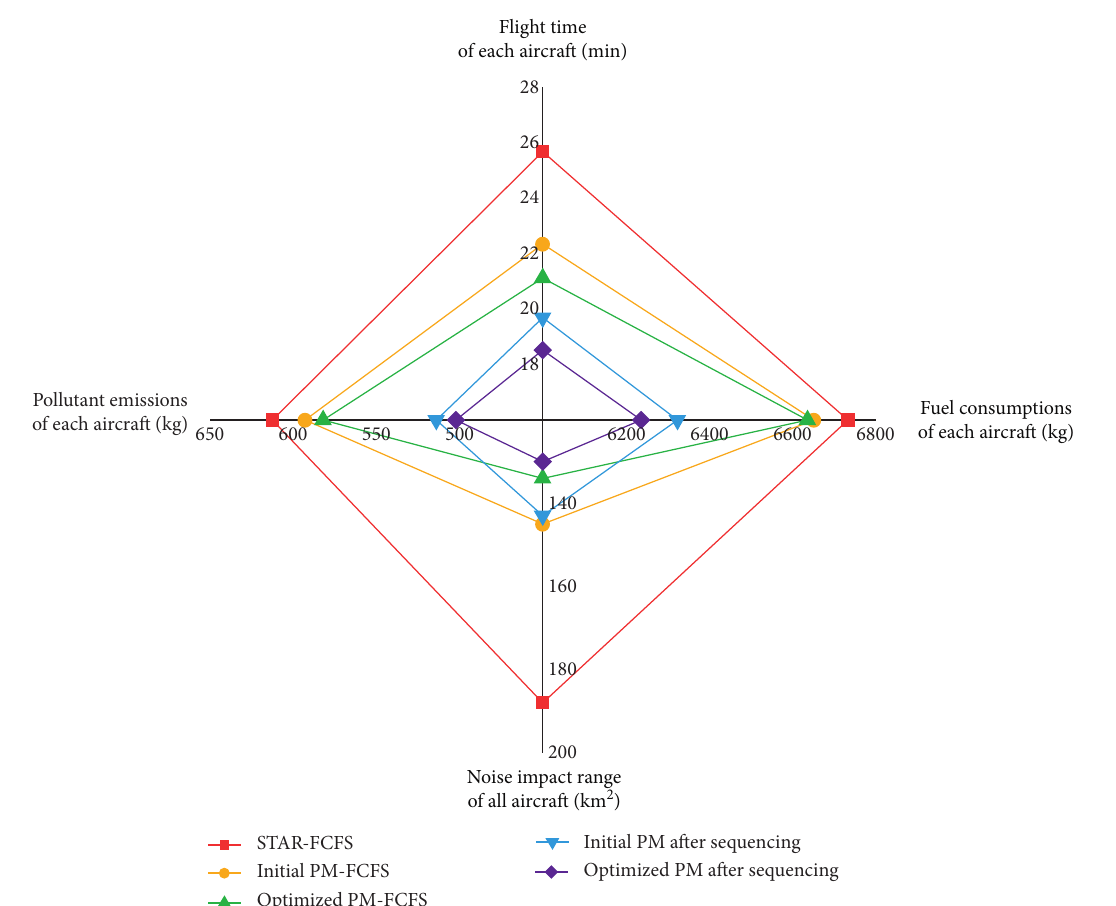
Figure 20: Comparison of operational benefits of arrival